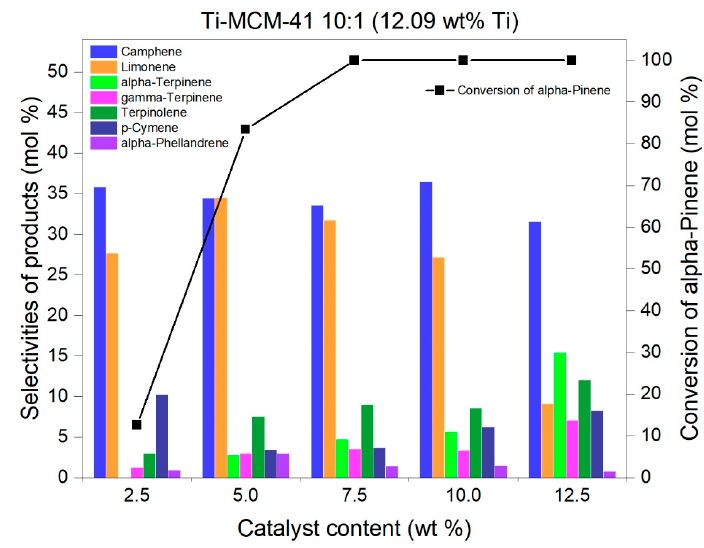
Figure 11. The influence of the Ti-MCM-41 10:1 catalyst content on the α -pinene conversion and on the product selectivity (temperature 160 °C, reaction time 6 h).